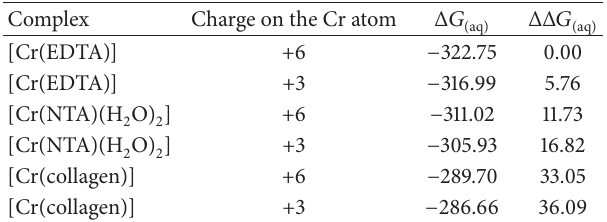
Table 1: Variation of the Gibbs free energy for complexation reaction in kcal ⋅ mol − 1